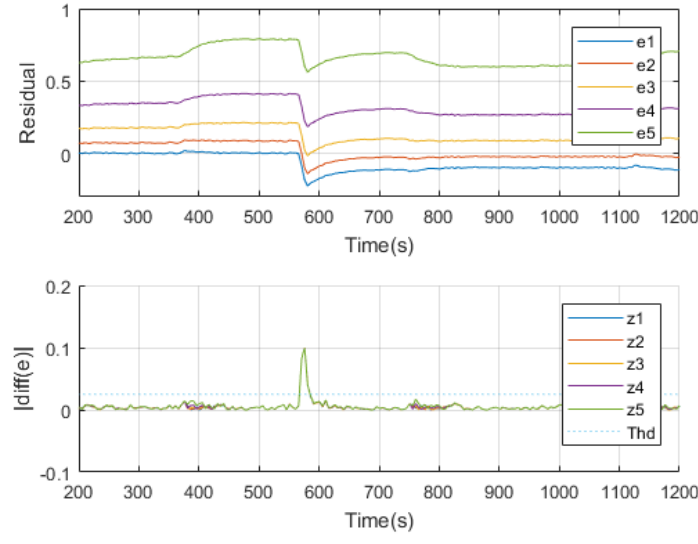
Figure 7. FDI process using interval unscented Kalman filters.